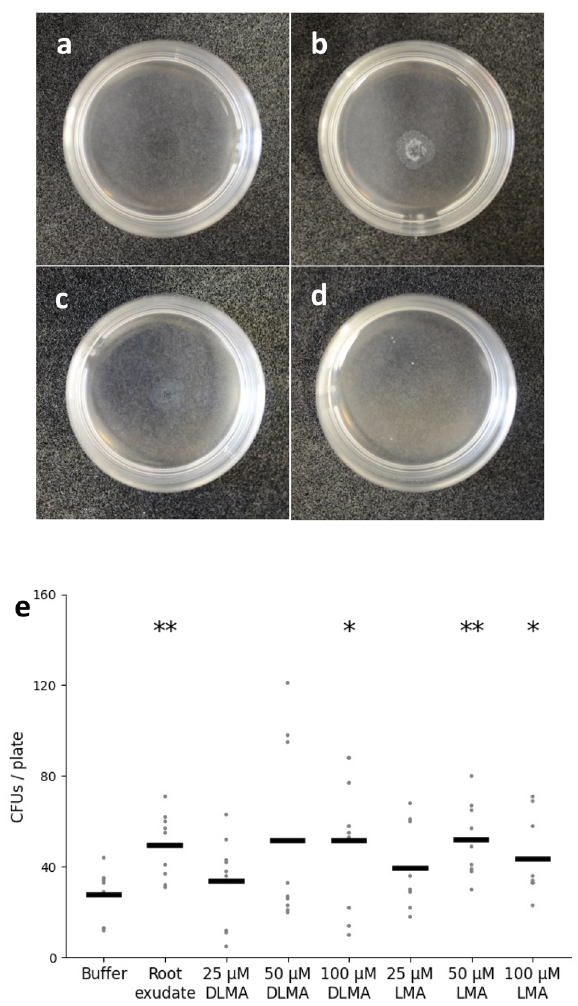
Figure 1. Chemotactic response of Bacillus firmus I-1582 towards Arabidopsis thaliana root exudates (AREs) ( a – e ) and organic acids (OAs) ( e ). Upper row: A drop of the test substance was placed in the centre of a 35 mm diameter Petri dish containing B. firmus I-1582. A turbid ring indicated the aggregation of bacteria. 10 µl of chemotaxis buffer (A); 10 µl of AREs extracted from 7- ( b ), 21- ( c ), and 28- ( d ) day-old A. thaliana plants. Photographs are representative examples taken after incubation for 30 s at room temperature. Bottom graph ( e ): Chemotactic response of B. firmus I-1582 towards AREs of 7-day-old seedlings and OAs in a capillary assay. DLMA dl-malic acid, LMA l-malic acid, AREs A. thaliana root exudates, OAs organic acids. Results are expressed as the mean ± standard error of three independent biological replicates (n = 9). Data are statistically analysed using Student’s t test. Asterisk (*) indicate statistically significant differences compared with the control (* p < 0.05, ** p <